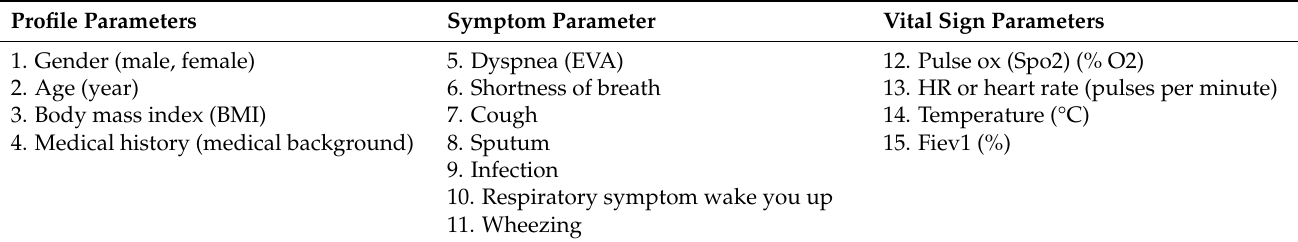
Table 2. List of COPD patient parameters.